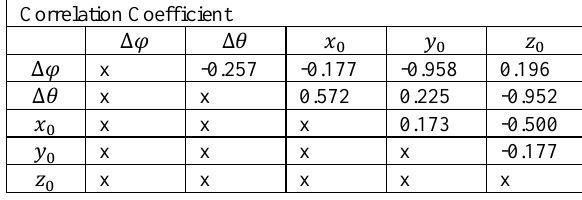
Table 4. Correlation coefficient of estimated parameters of